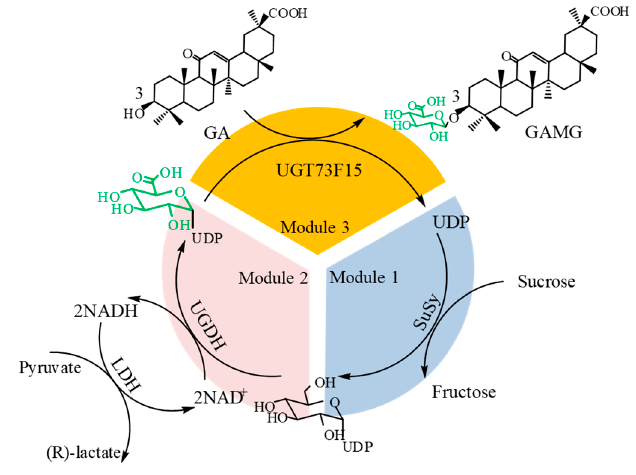
Figure 5. Schematic representation of GAMG synthesis using UGT73F15 as catalyst, based on in situ regeneration of UDP-GlcA by combination of sucrose synthase (SuSy), UDP-Glc-dehydrogenase (UGDH), and lactate dehydrogenase (LDH). Table 2. Properties of enzymes utilized in this